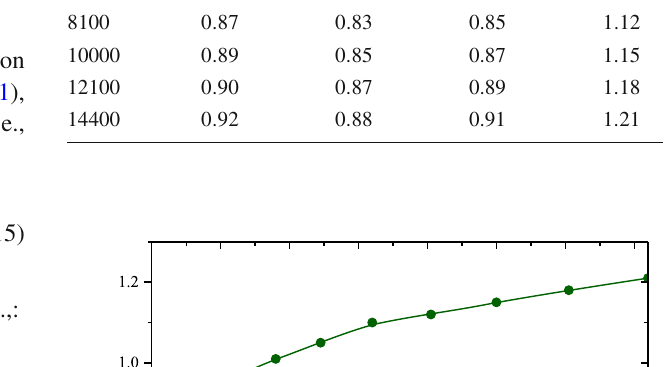
Fig. 4 The z max versus the hard scale Q 2 [21]. See the text for more explanations